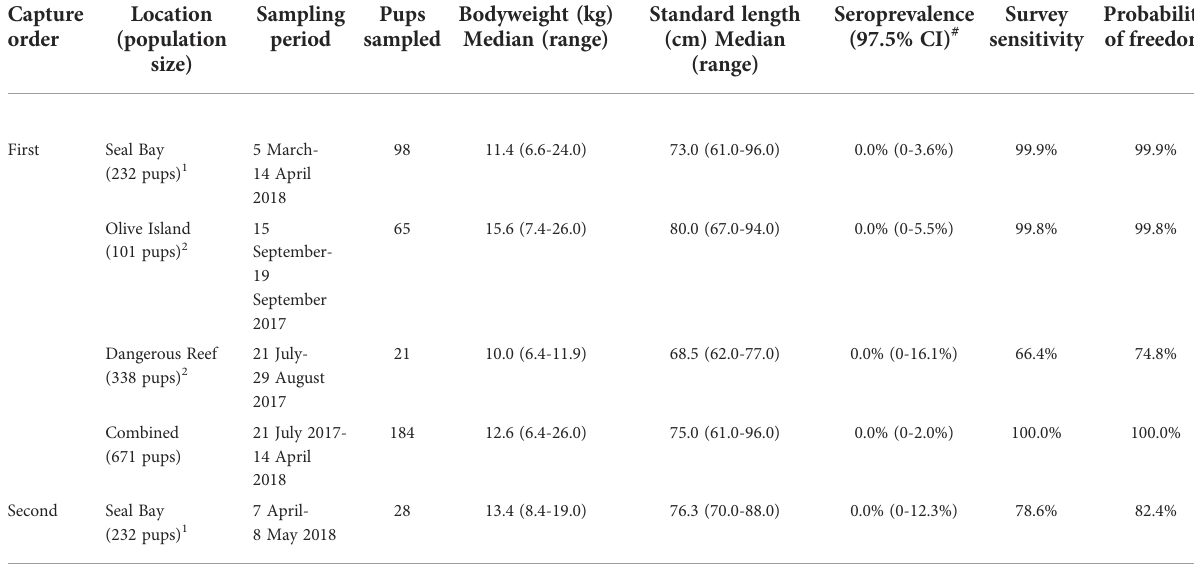
TABLE 1 Results of a serosurvey of Australian sea lion ( Neophoca cinerea ) pups for T. gondii antibodies sampled at three South Australian colonies, using a modi fi ed agglutination test (MAT). Capture Location order (population